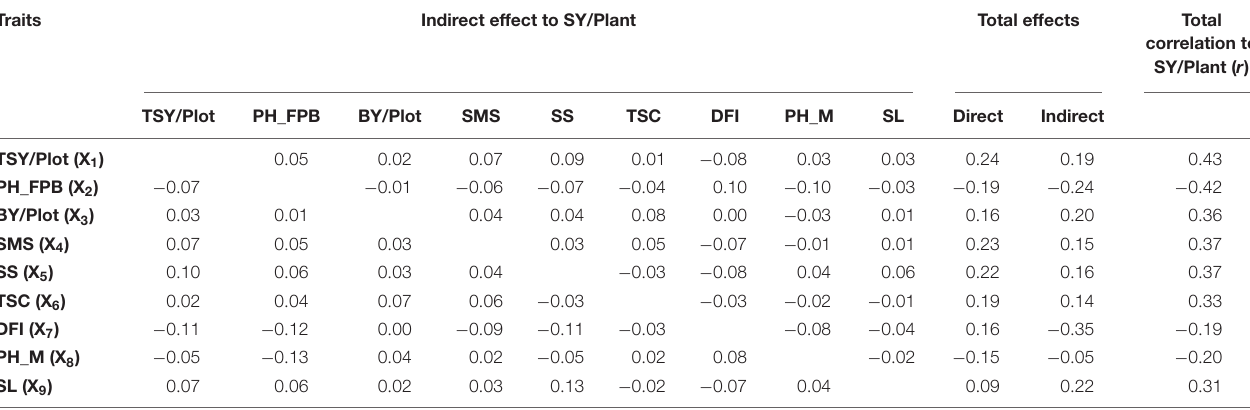
TABLE 4 | A path coefficient showing total, direct, and indirect effect of various key traits identified on seed yield per plant in mustard.